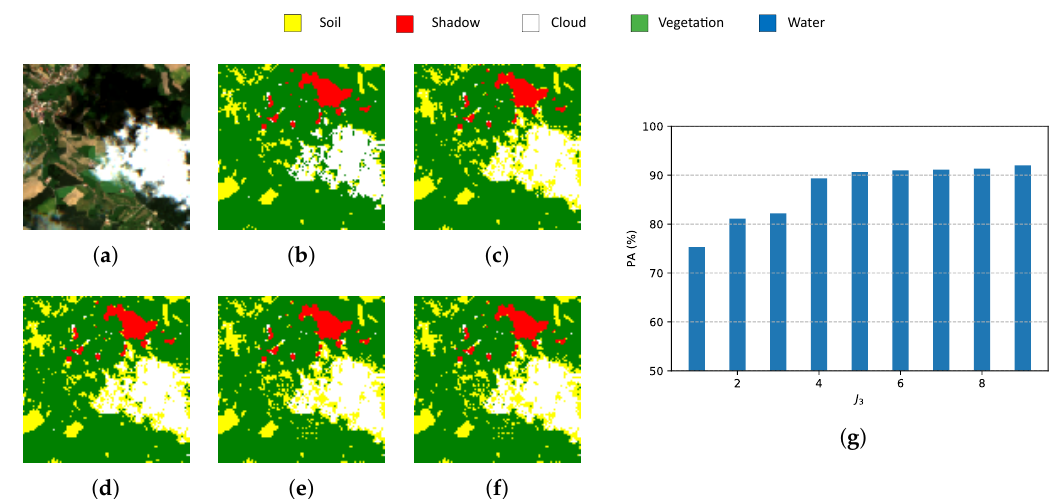
Figure 9. Qualitative results testing a scene of interest with abundant vegetation, and presence of shadows and clouds. ( a ) Original true color scenario of 128 × 128 pixels, in Central Europe: ( b ) five classes semi-manually labeled ground truth of the MSIs, ( c ) classification with an unsupervised normalized difference index (NDI) fusion algorithm, and ( d ) output prediction after 100 epochs in the FCN used for this work without data compression. ( e ) PCA-FCN framework output; ( f ) prediction of the whole framework HOOI-FCN proposed in this work; and ( g ) PA behavior of the HOOI-FCN versus number of tensor bands.